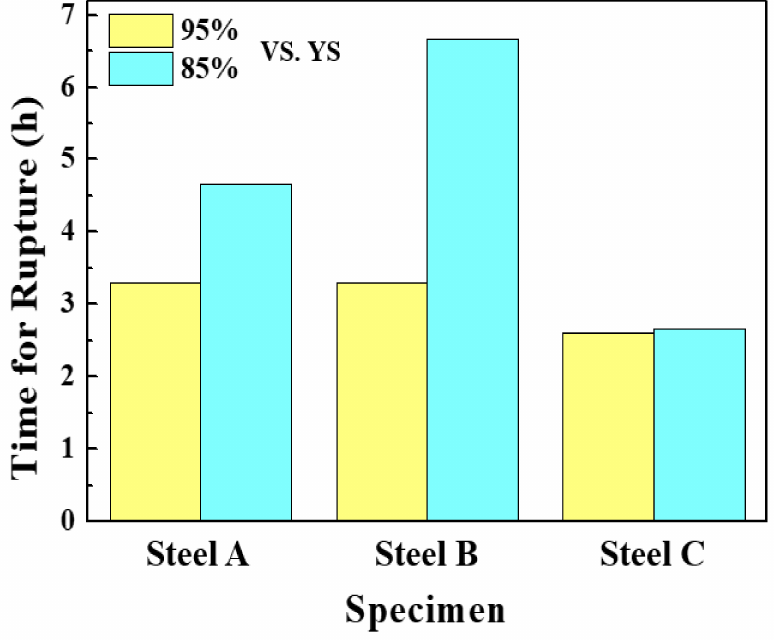
Figure 10. Time for rupture of the three samples, obtained by the SSC